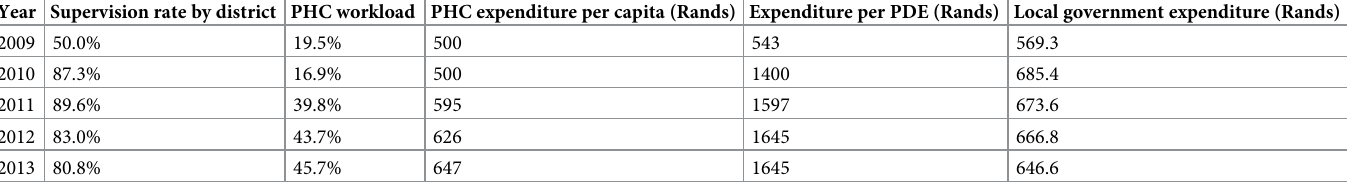
Table 3. Number of supervision rate, PHC workload, PHC Expenditure per PDE, PHC expenditure per capita and local government expenditure between 2009 and 2013.